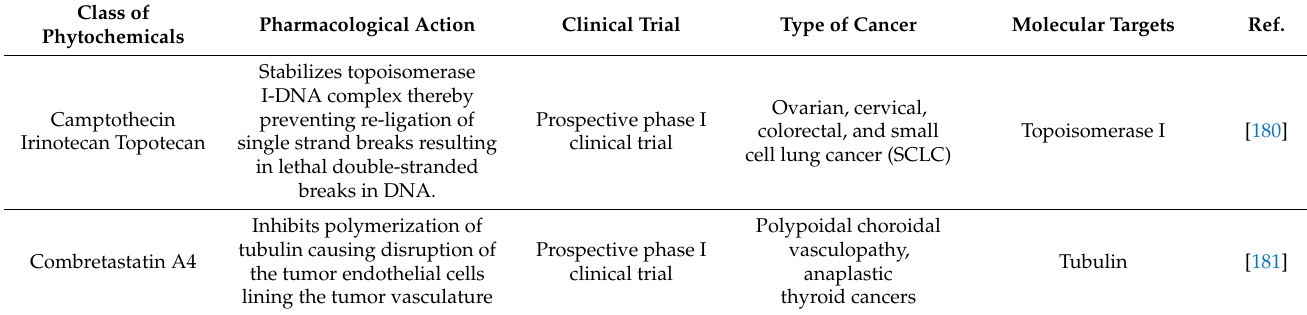
Table 2. Plant derived drugs investigated under clinical